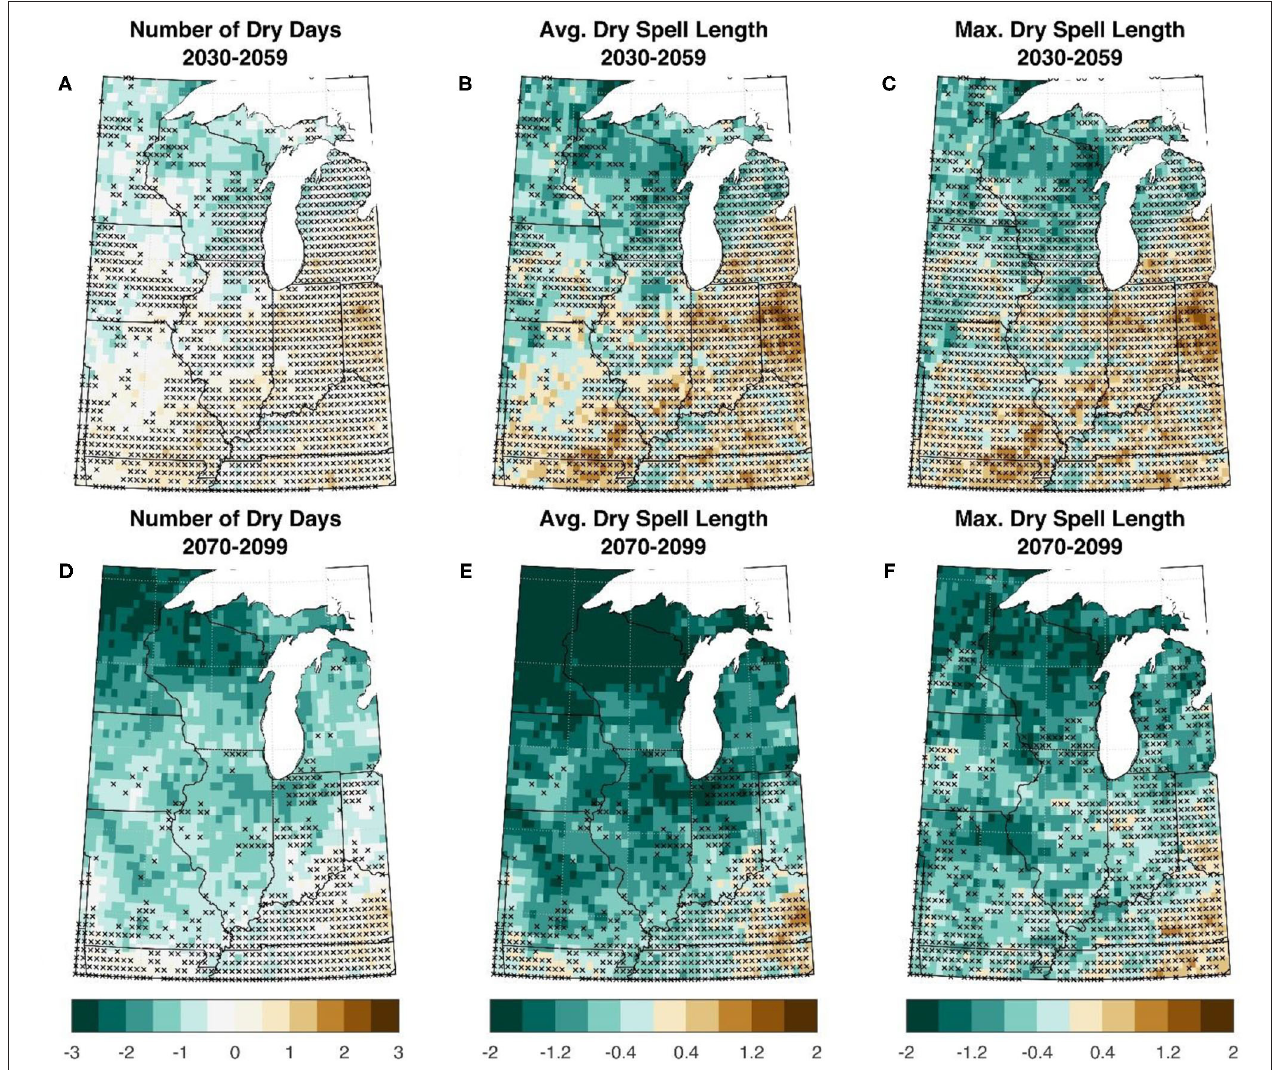
FIGURE 4 | The projected change in the 30-year spring climatology of the NA-CORDEX multi-model ensemble median in mid- (2030–2059) and late-century (2070–2099), relative to the model historical period (1976–2005). Shown are the number of dry days (A,D) , the average dry spell length (B,E) , and the maximum dry spell length (C,F) . Stippling represents areas where fewer than 9 of the 12 simulations agree on the sign of the